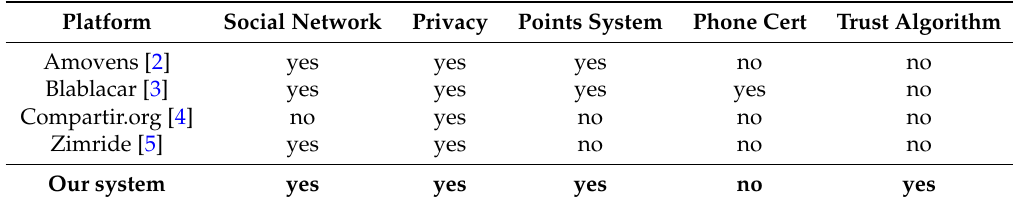
Table 1. Carpooling